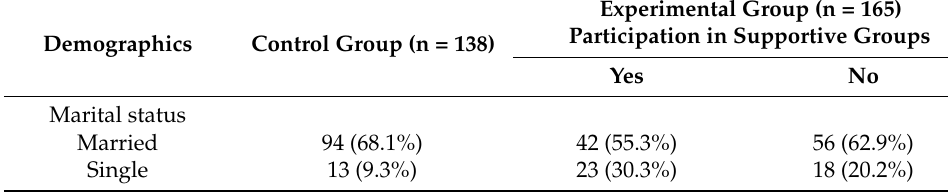
Table 2. Samples’